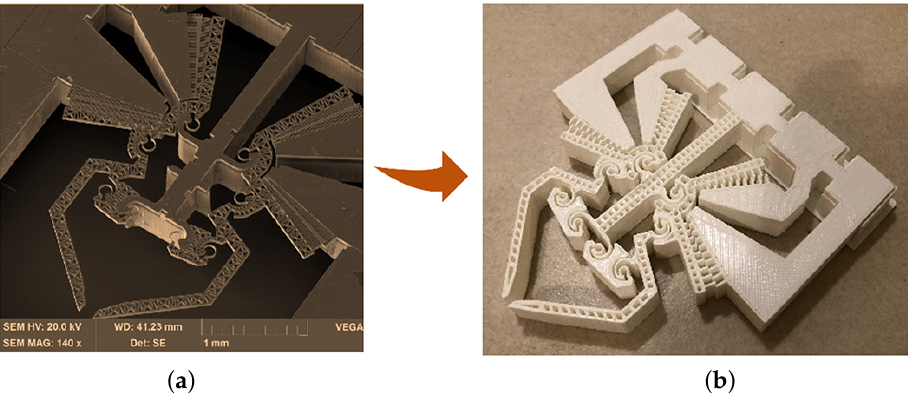
Figure 4. Comparison of the micro (see Ref. [14]) ( a ) and macro ( b ) grippers (second